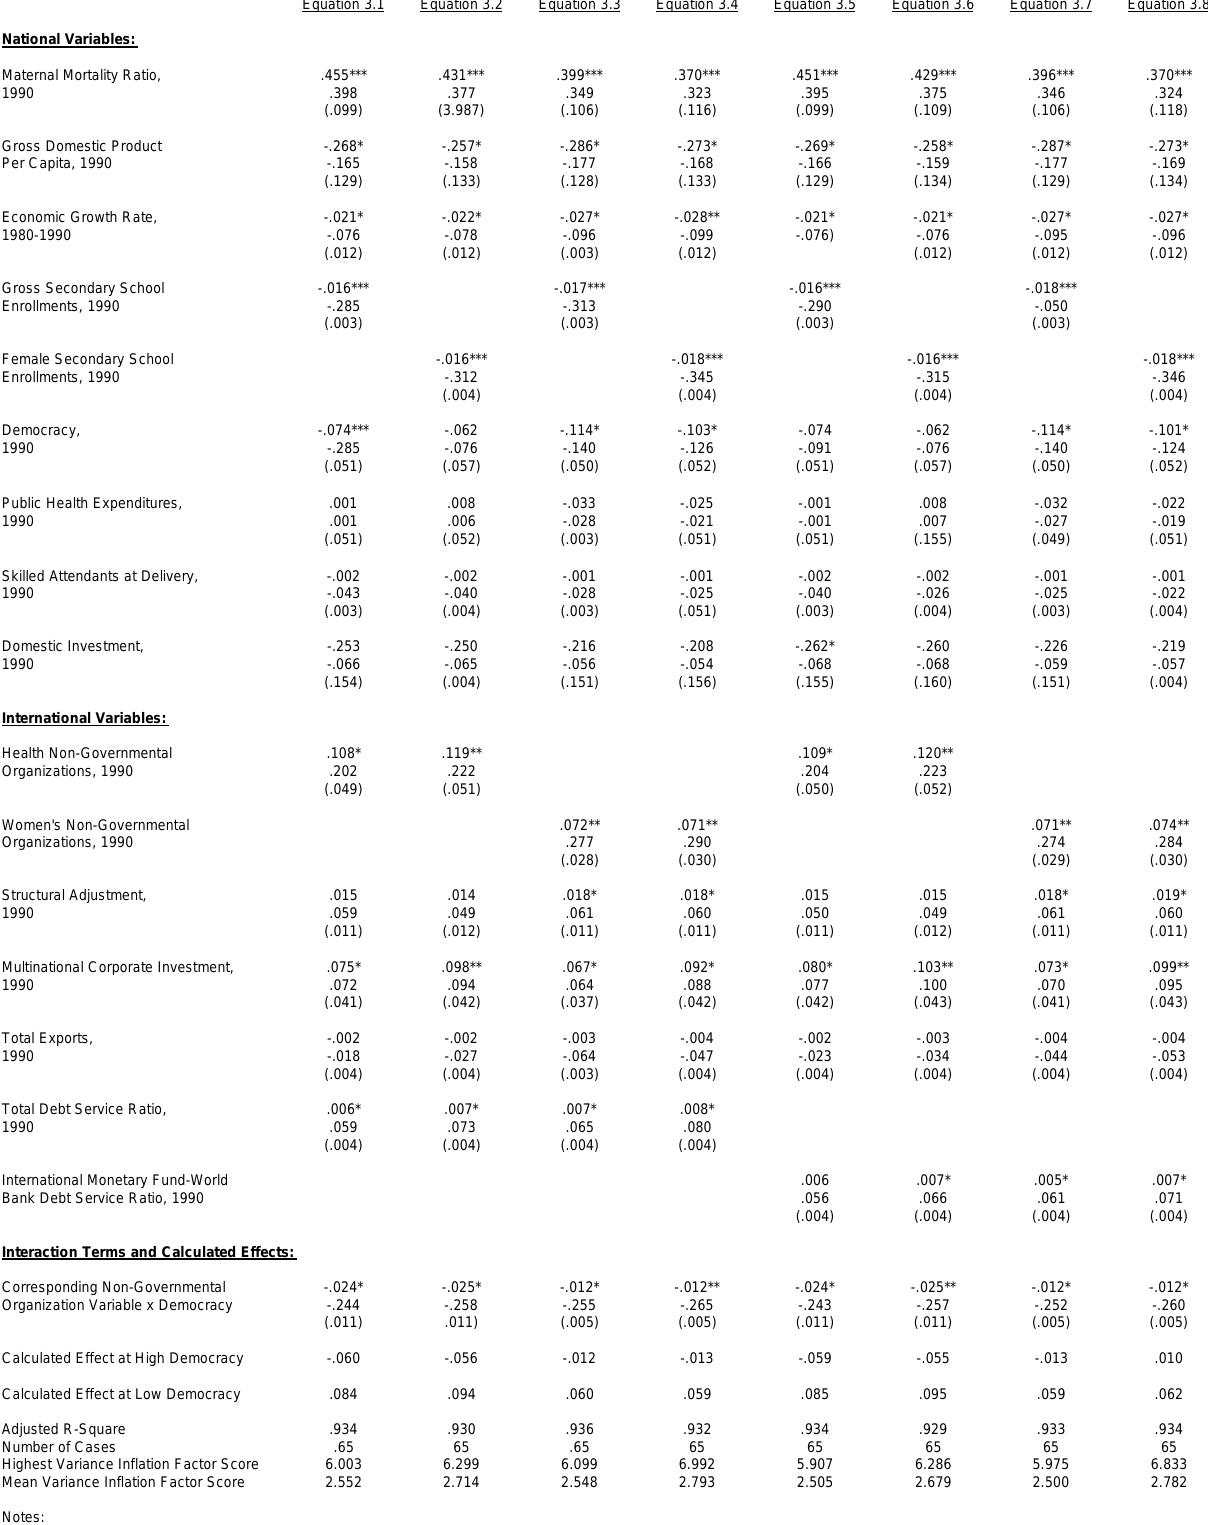
Table 3 Estimates of Maternal Mortality (1990-2005) Including Debt Service, Structural Adjustment, and Interaction Terms Between Non-Governmental Organizations and